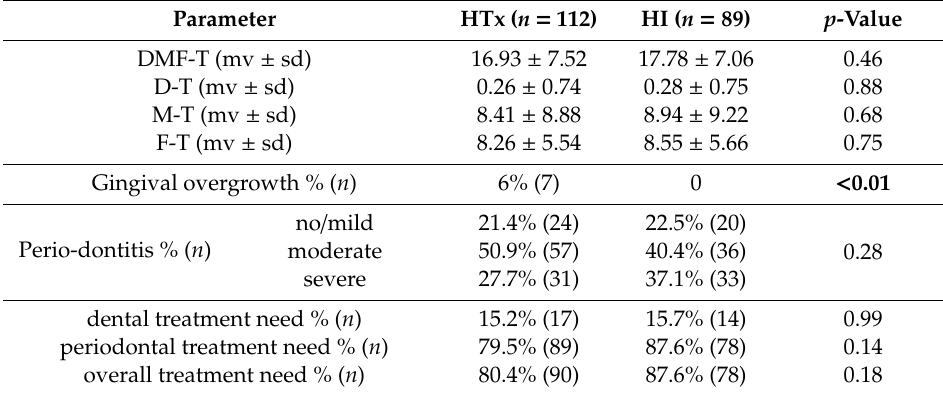
Table 4. Oral health situation between the two groups, significance level: p < 0.05.